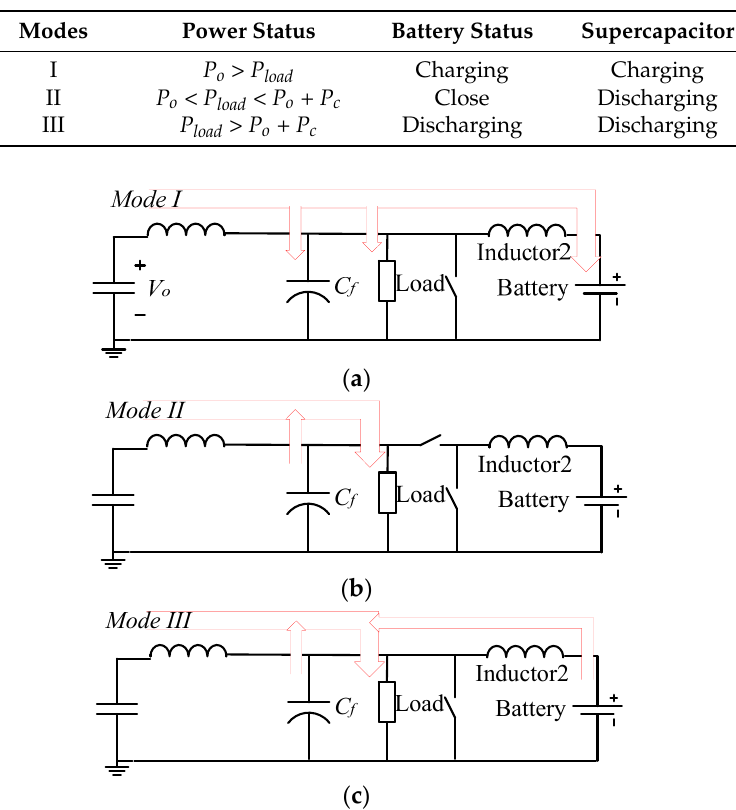
Figure 7. Three modes of the energy flow of the system ( a ) supercapacitor and batteries storage; ( b ) supercapacitor discharge and ( c ) battery discharge.